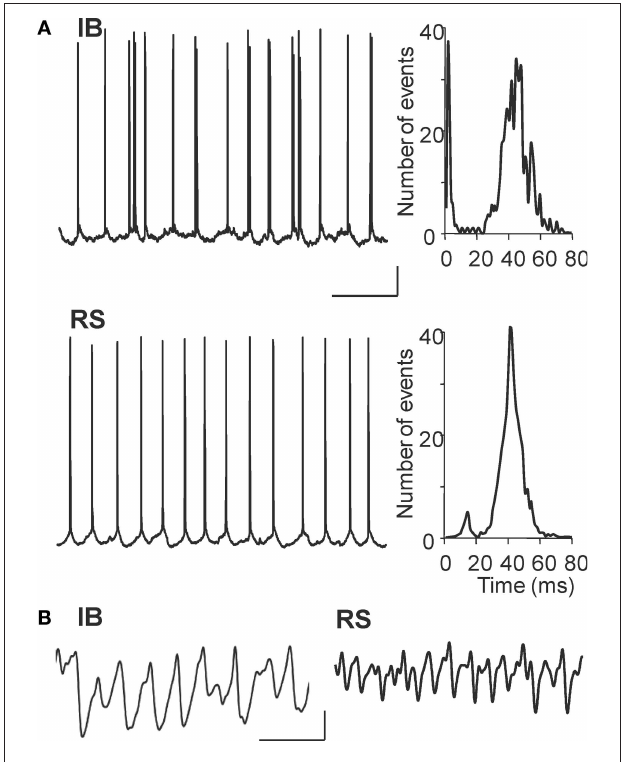
FiGurE  | Cholinergic neuromodulation generates beta frequency outputs from layer V principal cells in Au. (A) Example intracellular recordings from a layer V IB cell and RS cell at rmp during carbachol-induced beta2 oscillations in the 1 ° auditory cortex. Corresponding event histograms on the right show interspike intervals for both cells correspond to the population beta2 rhythm in experiment. (B) Example recordings from IB and RS cells at − 30 mV membrane potential. Both cell types demonstrate prominent beta2 frequency inhibitory postsynaptic potentials, though the higher gamma frequency activity is also evident in RS cells. Scale bars 100 ms, 20 mV (A) , 100 ms, 5 mV/5 nS (B)